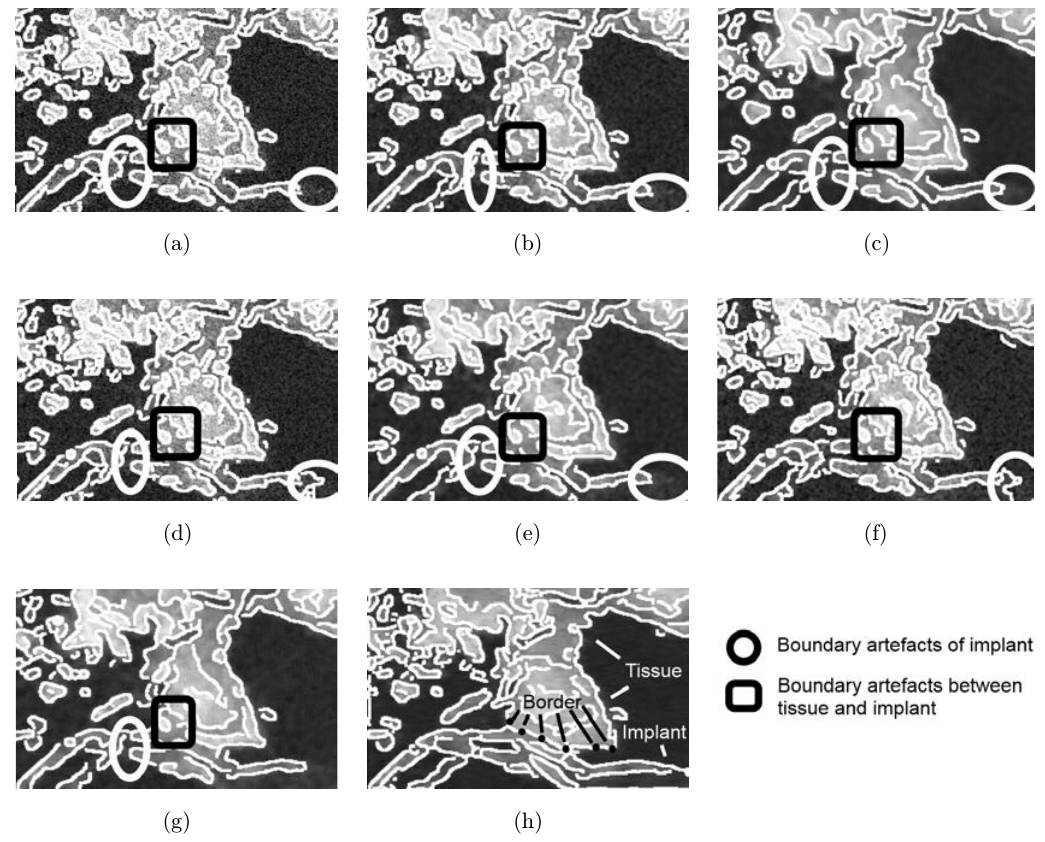
Fig. 5. Edge detection for Fig. 4 using Canny